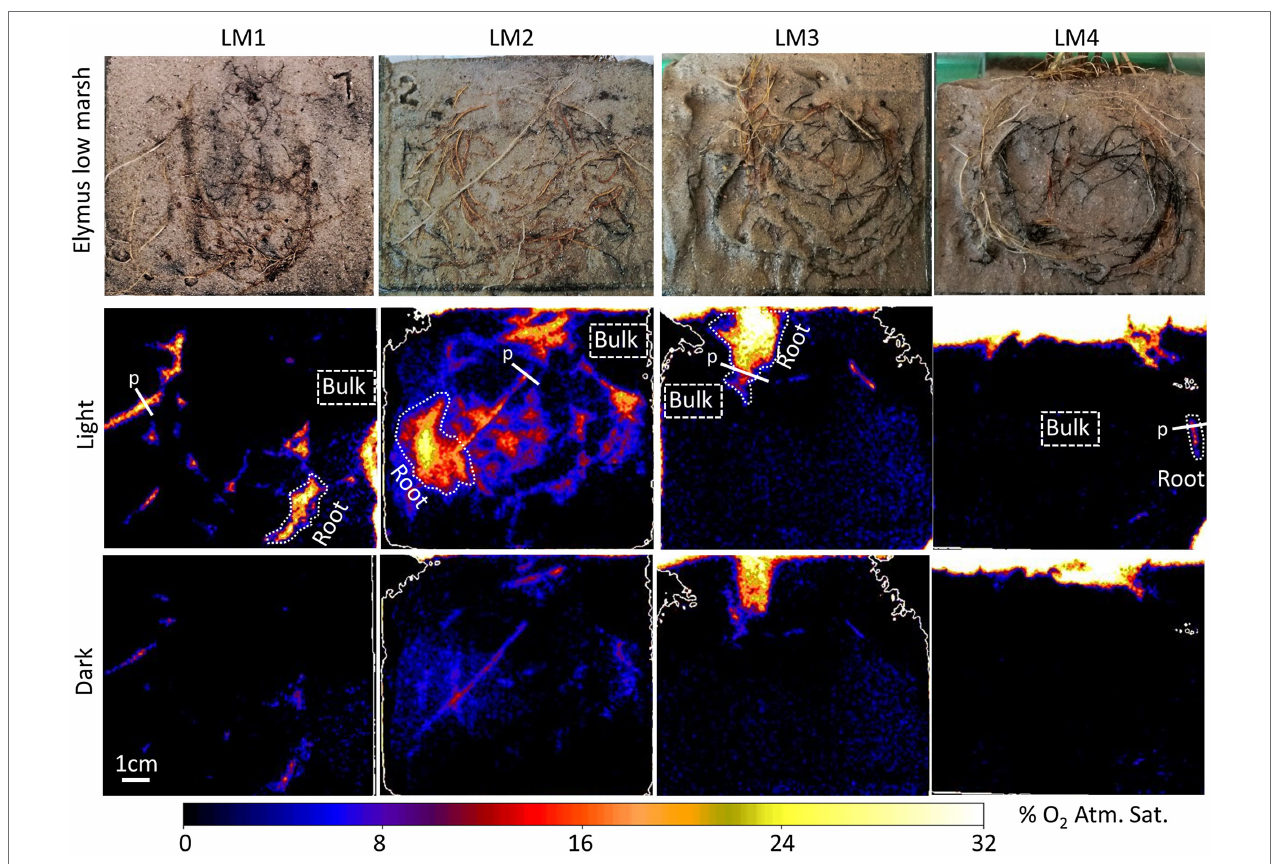
FIGURE 2 | Planar optode images of the O 2 distribution around selected roots of Elymus athericus – low-marsh ecotype from four independent samples (LM1– LM4), with and without illumination of the aboveground biomass. “Root” indicates specific oxic root zones, and “Bulk” indicates specific areas with bulk anoxic sediment selected for quantitative measurements shown in Figure 4 . “p” indicates the locations of the concentration profile shown in Figure 5